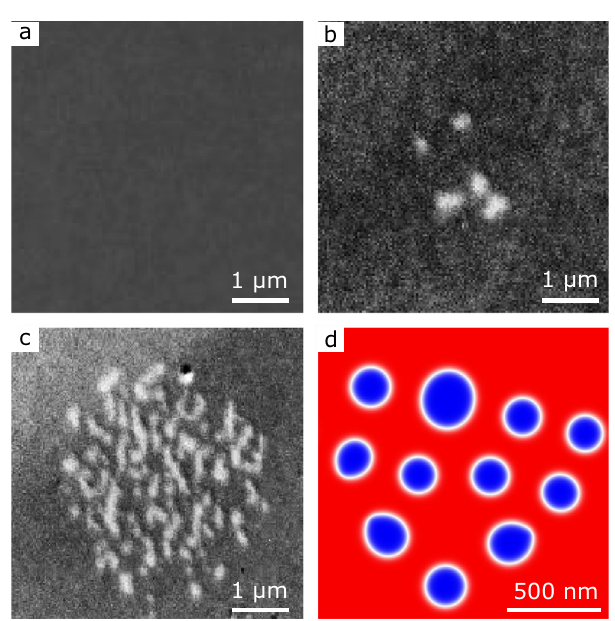
Fig. 5 | Nucleation ofSAF skyrmionsby ultra-fast laserpulses. a , b XMCD-PEEM images (Co L 3 edge) of a Pt(2.25)/[Pt(0.75)/Co(1.49)/Ru(0.85)] 6 (thicknesses in nanometres)SAFmultilayer( a )beforeand( b )duringtheilluminationofthesample by ultra-fast (80 fs) laser pulse excitation with repetition rate of 1.25 MHz and a fl uenceof10±3.5mJcm − 2 inthecentreofthebeam( c )XMCD-PEEMimageofworm domains and skyrmions after the continuous illumination (several minutes) by ultra-fast laser pulses with a fl uence of 7.0±2.5 mJ cm − 2 . The experiments were carried out at zero fi eld. d Micromagnetic simulation using experimental para- meters. Magnetisation distribution ( m z in colour scale (cf Fig. 2 a ) obtained after relaxation from a random initial state, mimicking a fully demagnetised state resulting from the laser excitation. Scale bars in a , b , c , d are 1 μ m and 500 nm,